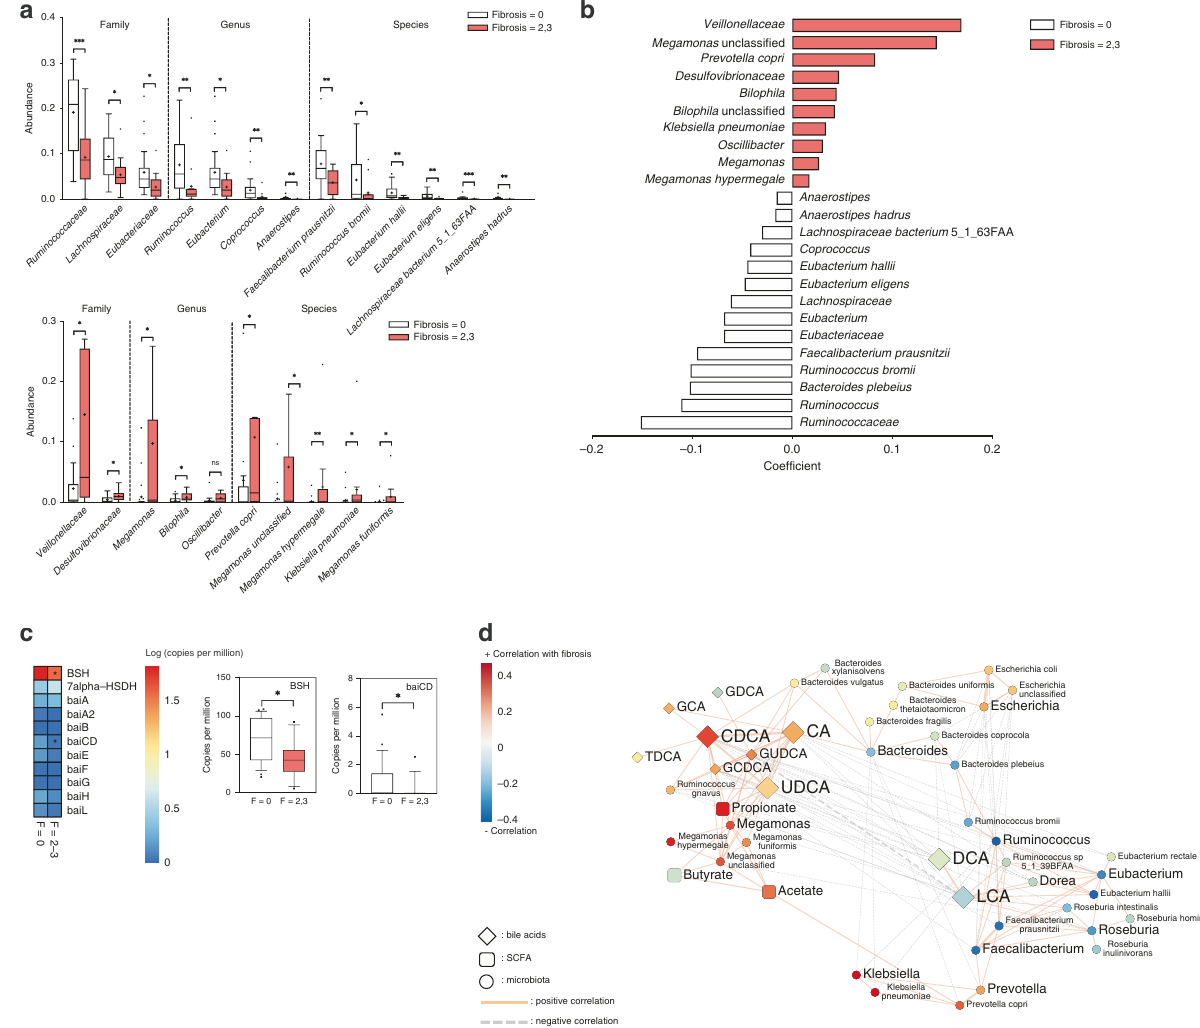
Fig. 7 Identi fi cation of fi brosis-related bacteria in non-obese subjects using metagenomic shotgun analysis. Stool metagenome analysis of 38 non- obese subjects was conducted (F0, n = 25; F2 – 3, n = 13). a Abundances of fi brosis-related taxa are depicted for clarity. Taxa enriched in subjects with fi brosis stage 0 (top) and fi brosis stage of 2 or 3 (bottom). Statistical analysis was performed using a two-sided nonparametric Mann – Whitney test. The P values are as follows: (top) *** P = 0.0009, * P = 0.0113, * P = 0.0124, ** P = 0.0024, * P = 0.0124, ** P = 0.0051, ** P = 0.0049, ** P = 0.0070, * P = 0.0451, ** P = 0.0041, ** P = 0.0011, *** P < 0.0001, and ** P = 0.0022; (bottom) * P = 0.0294, * P = 0.0346, * P = 0.0136, * P = 0.0163, * P = 0.0411, * P = 0.0164, ** P = 0.0050, * P = 0.0112, and * P = 0.0336. b Multivariate associations between speci fi c gut-microbiome components and fi brosis severity. Arcsine-root transformed abundances of bacteria were regressed against age, sex, and BMI. Only signi fi cant coef fi cients ( P < 0.05) are depicted, and the color inside the box represents the enriched fi brosis group. c Heatmap showing the abundances of microbial genes related to bile acid metabolism pathway (left). The box plots indicate the median, 25th to 75th percentiles (boxes), and 10th to 90th percentiles (whiskers) (right) (* P = 0.0124 and * P = 0.0237). d Network pro fi les between microbial taxa and stool metabolite components. Coef fi cients among genus, species-level bacteria, and stool metabolite components were calculated by SparCC. Coef fi cients ( P < 0.05) are depicted using Cytoscape. The P -value for each coef fi cient was obtained by bootstrapping the dataset 500 times and applying SparCC to each of those 500 datasets. The solid line (orange) and dotted line (gray) indicate positive and negative correlations, respectively. The shape of the node denotes the components used in this study (ellipse: microbiome, diamond: stool bile acids, and round rectangle: SCFAs) and the color indicates the degree of correlation with fi brosis severity. * P < 0.05, ** P < 0.01, *** P < 0.001. Source data are provided as a Source data fi